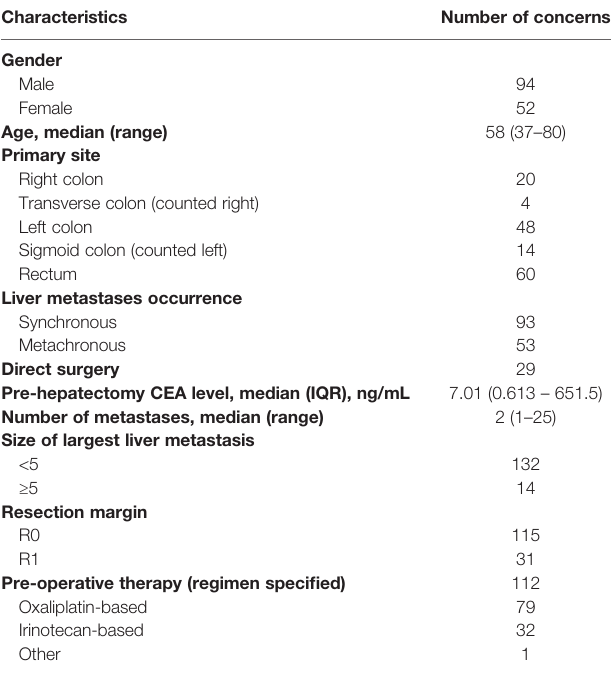
TABLE 1 | Clinical characteristics and pre-operative plans of the study population.